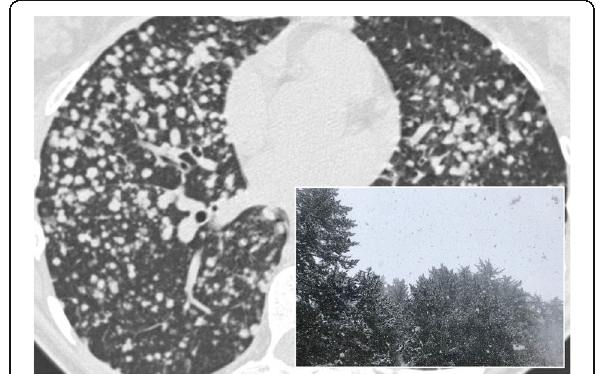
Fig. 31 Snowstorm sign. Innumerable nodules diffuse through the lung parenchyma, in a patient with diffuse metastatic disease from renal cell carcinoma. The multiple nodules in the lung parenchyma suggest a snowstorm appearance, as reproduced in the embedded